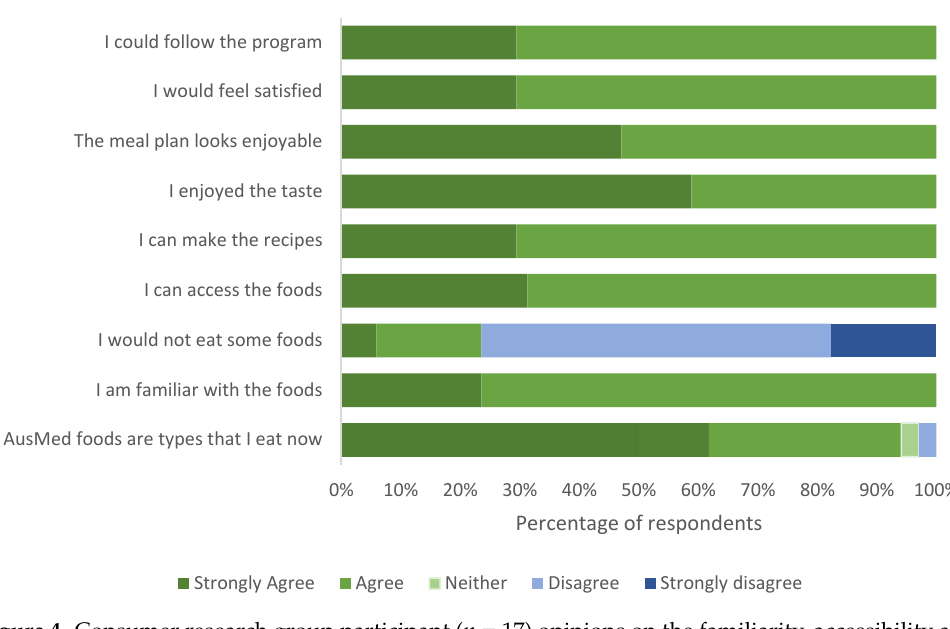
Figure 4. Consumer research group participant ( n = 17) opinions on the familiarity, accessibility and acceptability of the foods from the AusMed diet program and their ability to adhere to the AusMed meal plan.